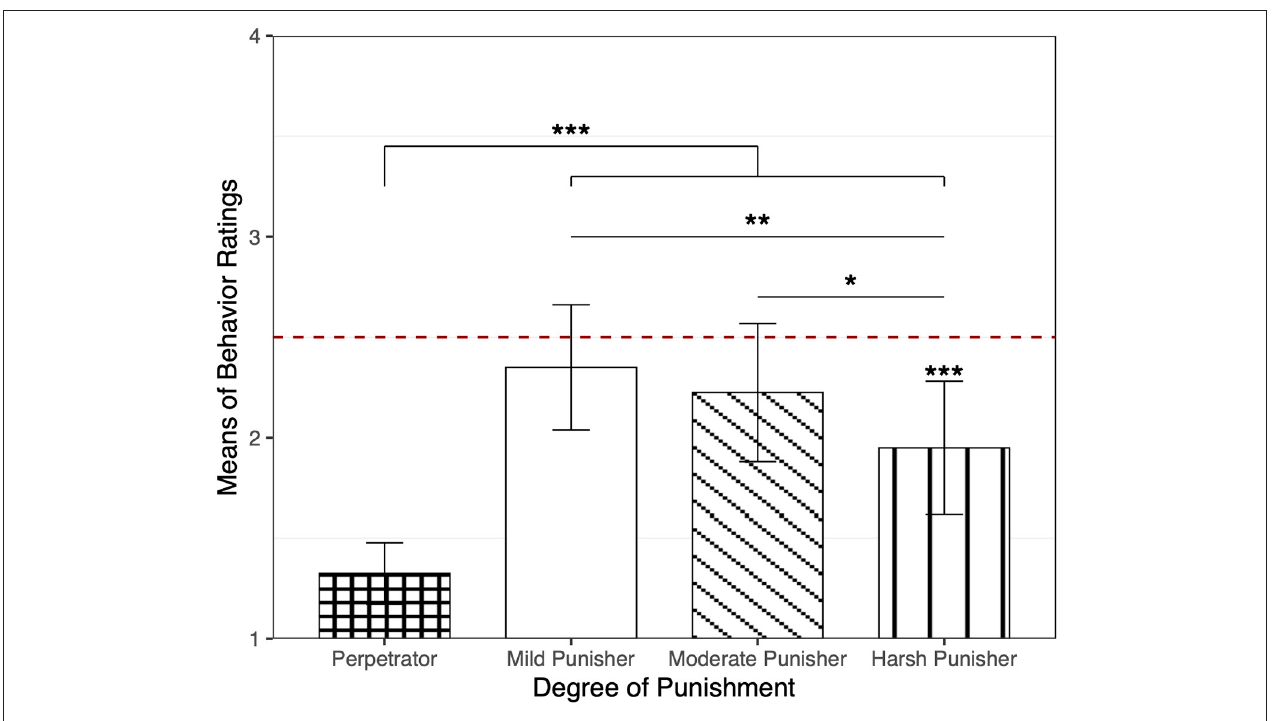
FIGURE 3 | Children’s behavior ratings of the 3 punishers in Experiment 4. Children’s behavior ratings of all the three punishers were significantly higher than the behavior rating of the perpetrator. The behavior ratings of the mild punisher and the moderate punisher were significantly higher than behavior ratings of the harsh punisher; and the behavior rating of the harsh punisher was significantly lower than the mid-point of the rating score. Error bars represent the 95% CI. *** p < 0.001, ** p < 0.01, * p < 0.05.